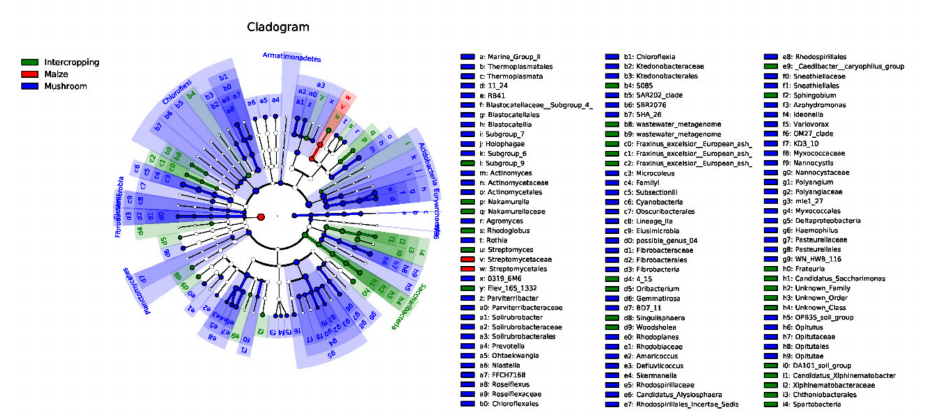
Figure 3. Relative abundances of the dominant phyla of bacteria at 0-20-cm soil depths under maize monoculture, mushroom monoculture and maize–mushroom intercropping. The number of replicates per treatment is 4 ( n = 4).